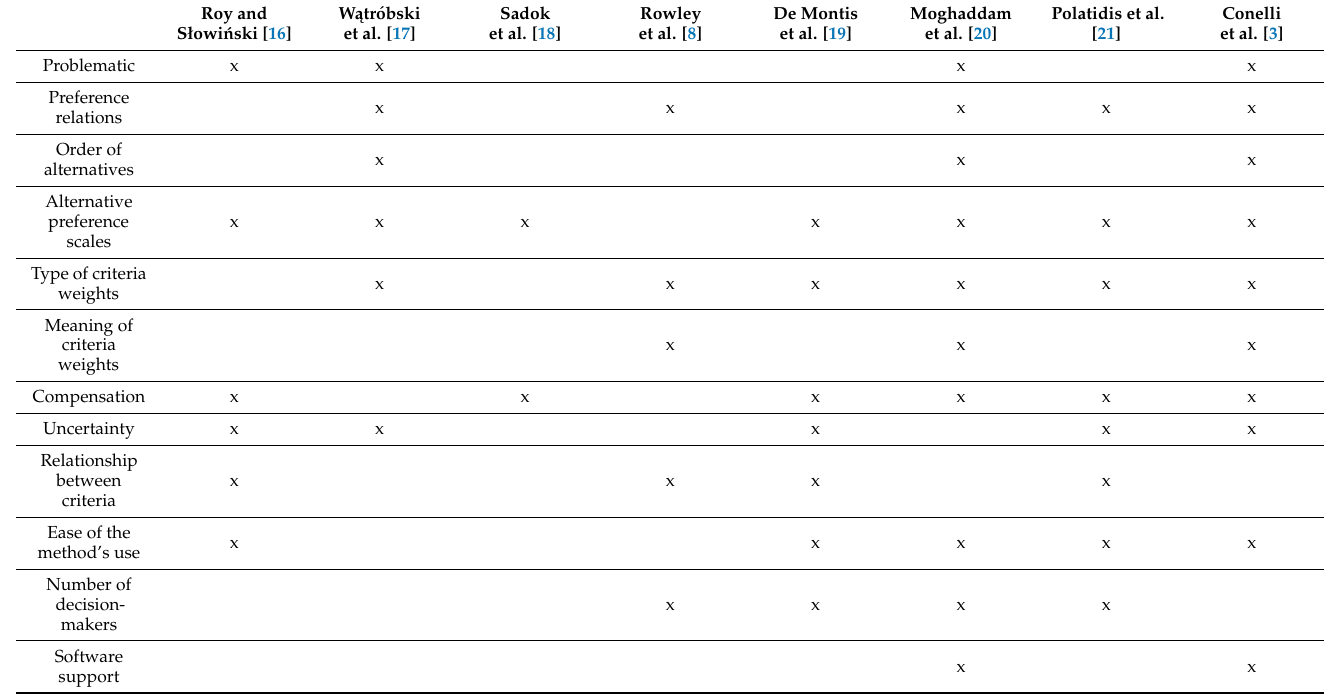
Table 1. Features of multi-criteria methods determining their applicability in problems of